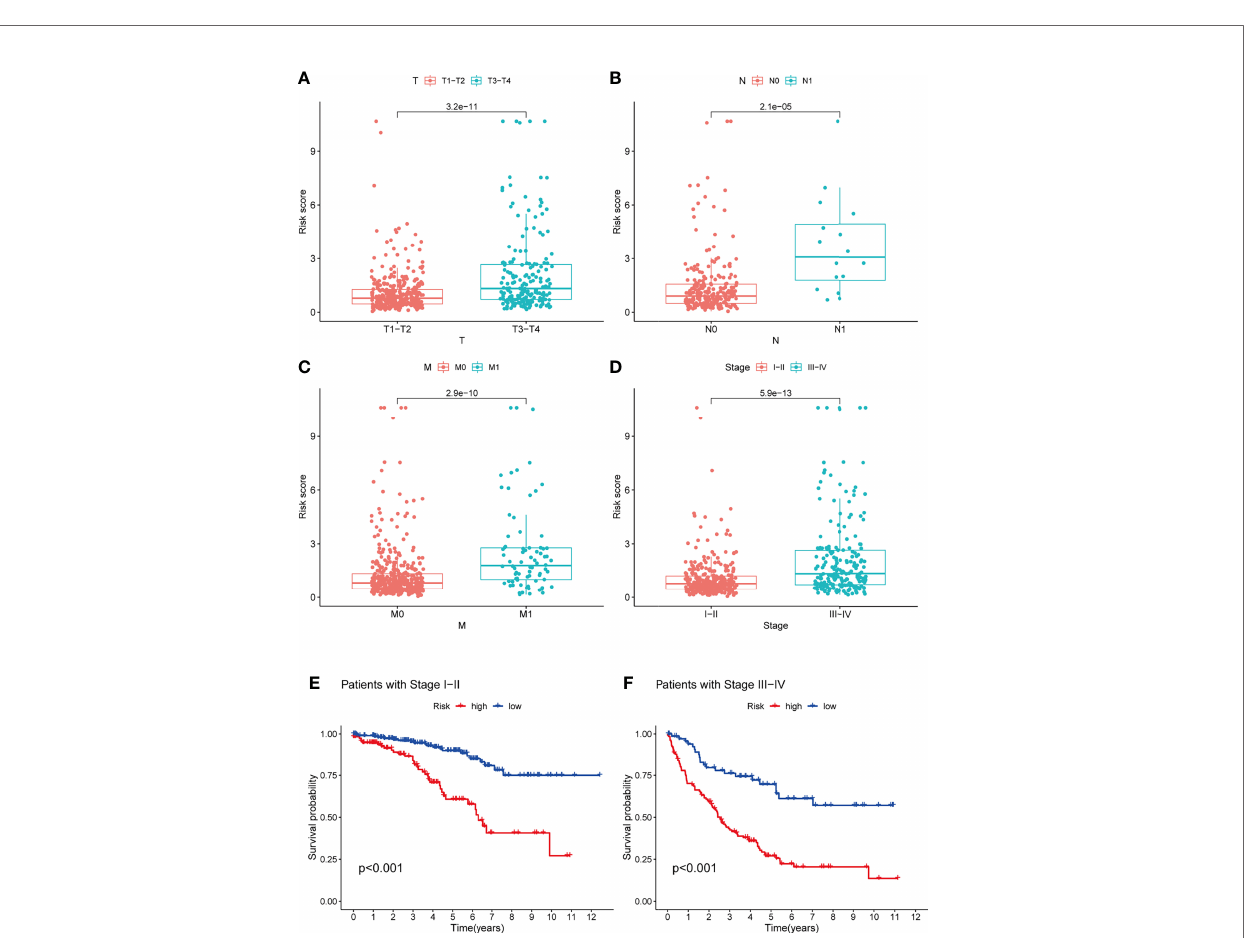
FIGURE 5 | Independent predictive analysis of TME related characteristics. In the whole TCGA cohort, ROC curves of our characteristics and other clinical indicators were analyzed for 1 year, 3 years and 5 years respectively (Figures A – C) . DCA curve analysis of our characteristics and other clinical indicators, the time is also one year, three years and fi ve years (Figures D, E) . Tumor microenvironment; ROC, receiver operating characteristics; Decision curve analysis.